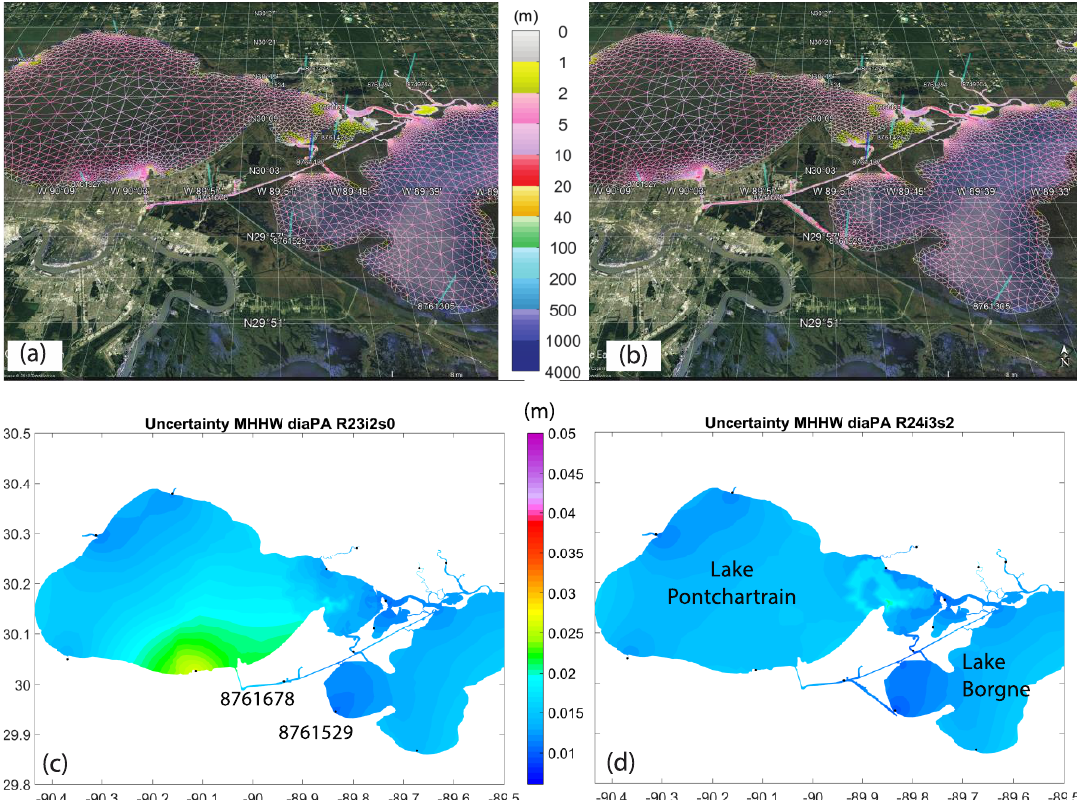
Figure 15. Sensitivity of spatially varying uncertainty to model error at intracoastal waterway station 8761678. ( a ) 8 cm and ( b ) 4 cm error at 8761678, Michoud substation, Intracoastal Waterway (ICWW), Louisiana. ( c ) and ( d ) Spatially varying uncertainty computed from the model grids in ( a ) and ( b ), respectively.